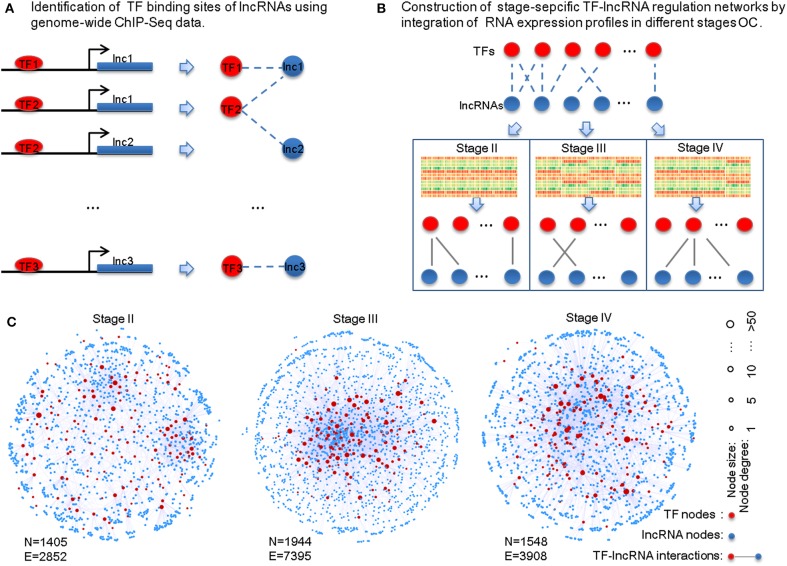
Construction of the stage-specific TF-lncRNA regulatory networks in OC. (A) Identification of conserved transcription factor binding sites on lncRNAs from ChIP-Seq datasets. (B) Identification of stage-specific TF-lncRNA relationships in different OC stages based on co-expression analysis. (C) Network illustration of the three stage-specific TF-lncRNA regulatory networks. N, nodes; E, edges.